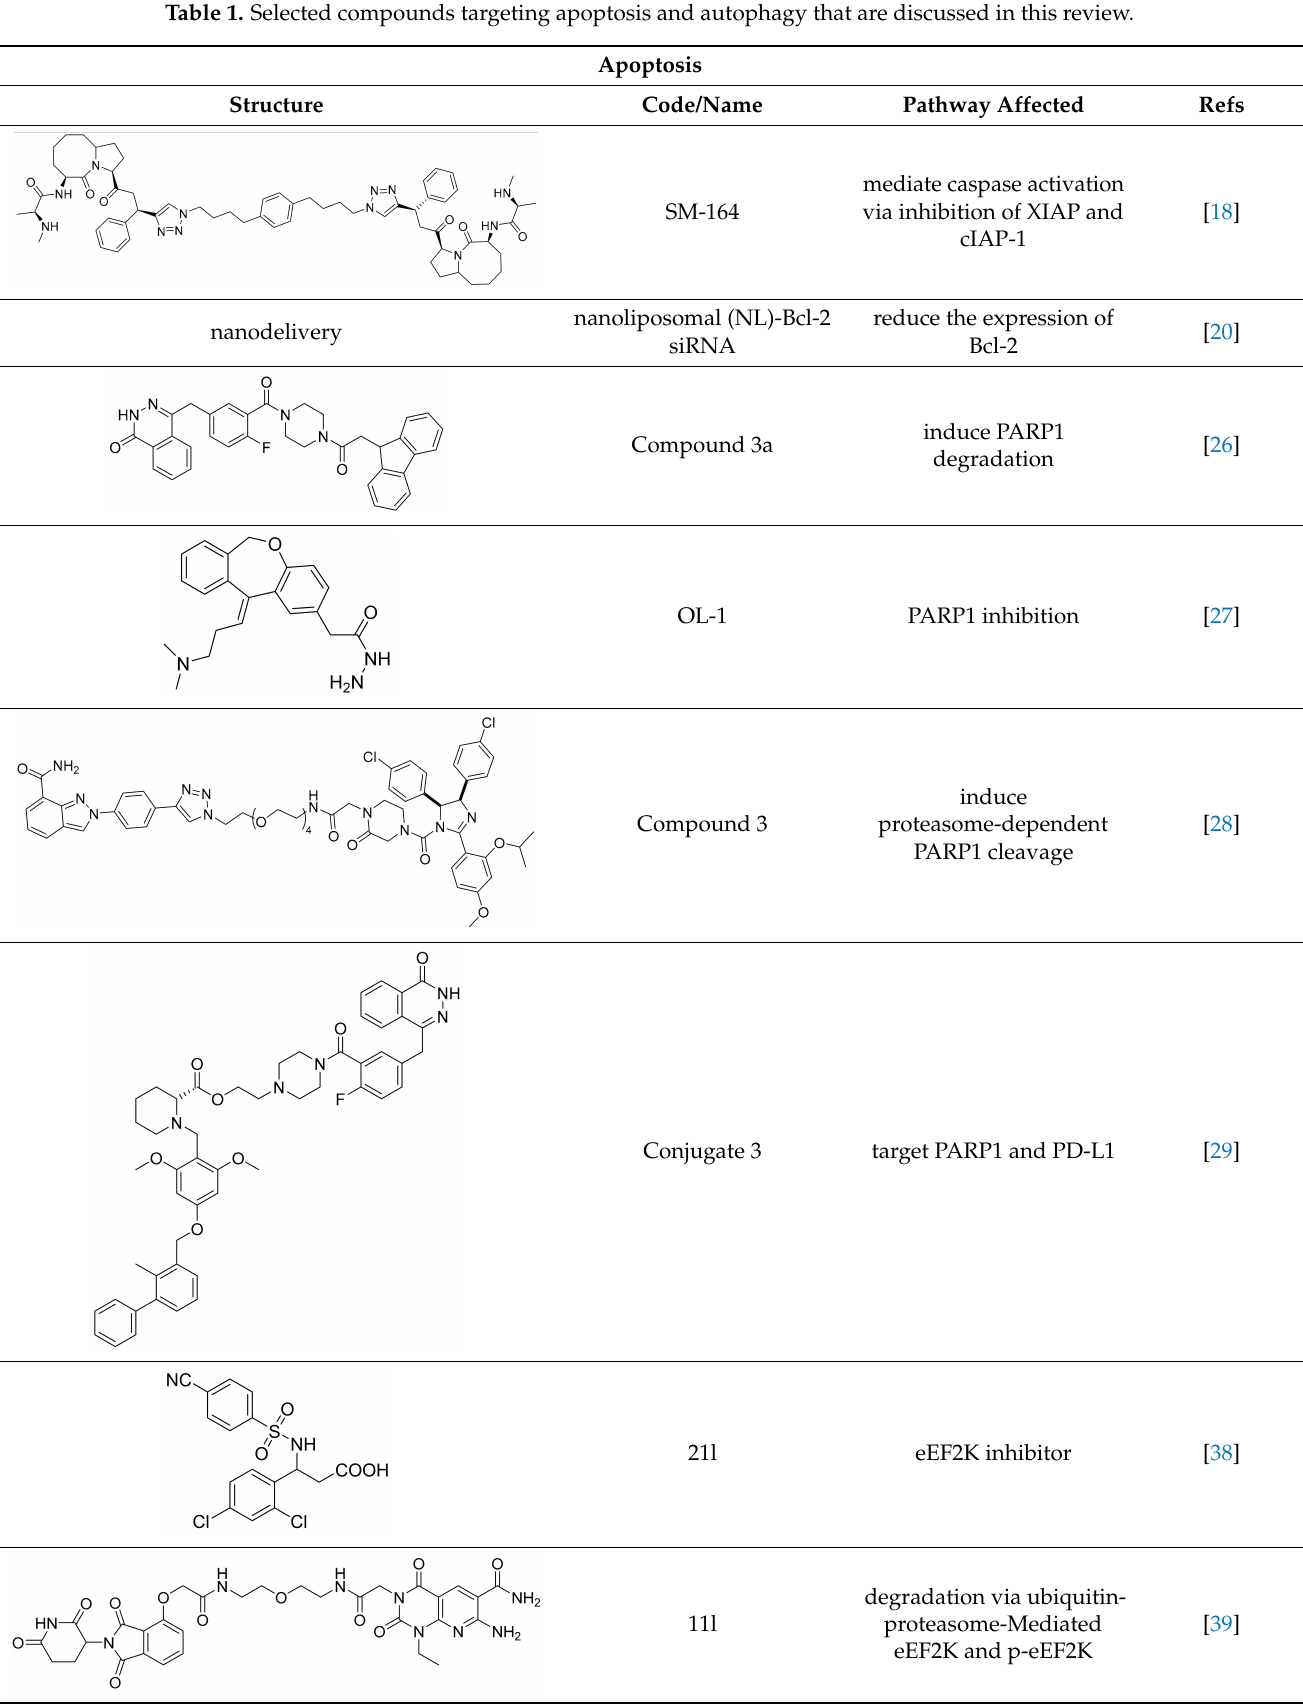
Table 1. Selected compounds targeting apoptosis and autophagy that are discussed in this